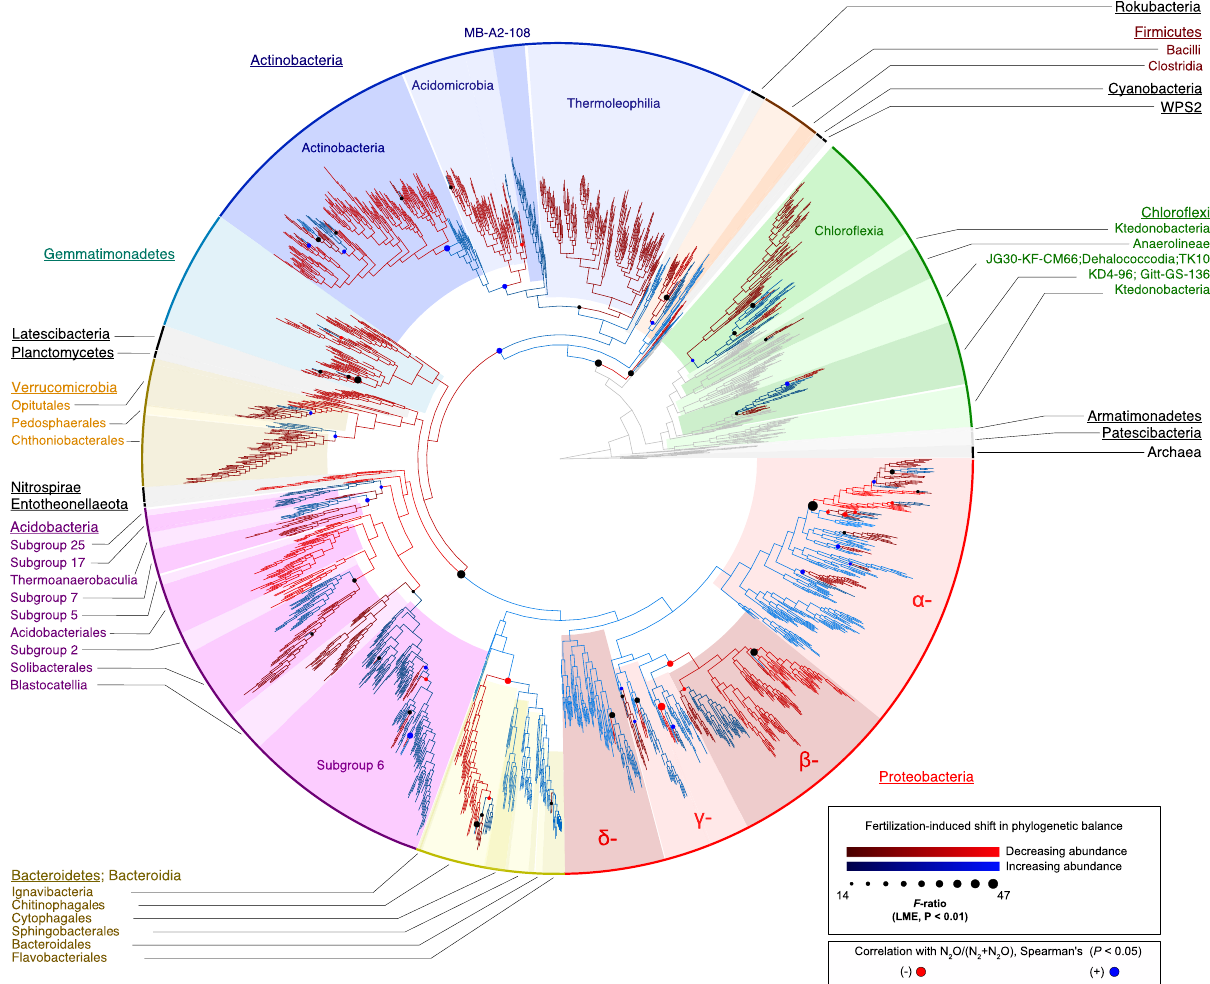
Fig. 2 Shifts in the phylogenetic composition of communities in response to long-term N fertilization across fi eld experiments, and their relationship with denitri fi cation end-product ratios (N 2 O/N 2 O + N 2 ). Signi fi cant shifts (false discovery rate corrected Pr( F ) < 0.01; N = 105 independent samples) in the balances of neighbouring clades as a result of fertilization are indicated by circles at respective nodes in the phylogeny. Branch colour denotes clades in each balance that have either increased (blue) or decreased (red) in response to fertilization. Node symbol size and branch colour hue re fl ect the strength of the fertilization effect, based on F -ratios obtained from linear mixed-effects models. Node symbol colour indicates whether changes in the balances are signi fi cantly associated (Spearman ’ s ρ , P < 0.05; N = 105 independent samples) with increased N 2 O/N 2 O + N 2 ratios (blue) or decreased ratios (red), or were not signi fi cantly associated